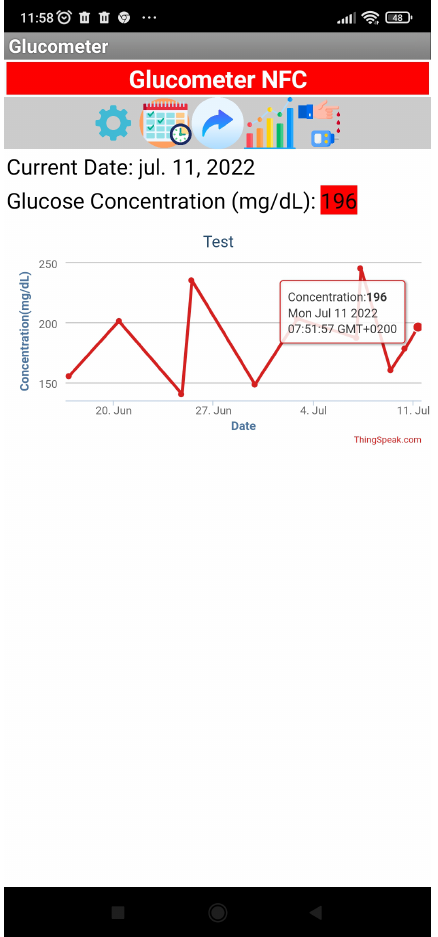
Figure 19. Smartphomneapp screen used to record glucometer